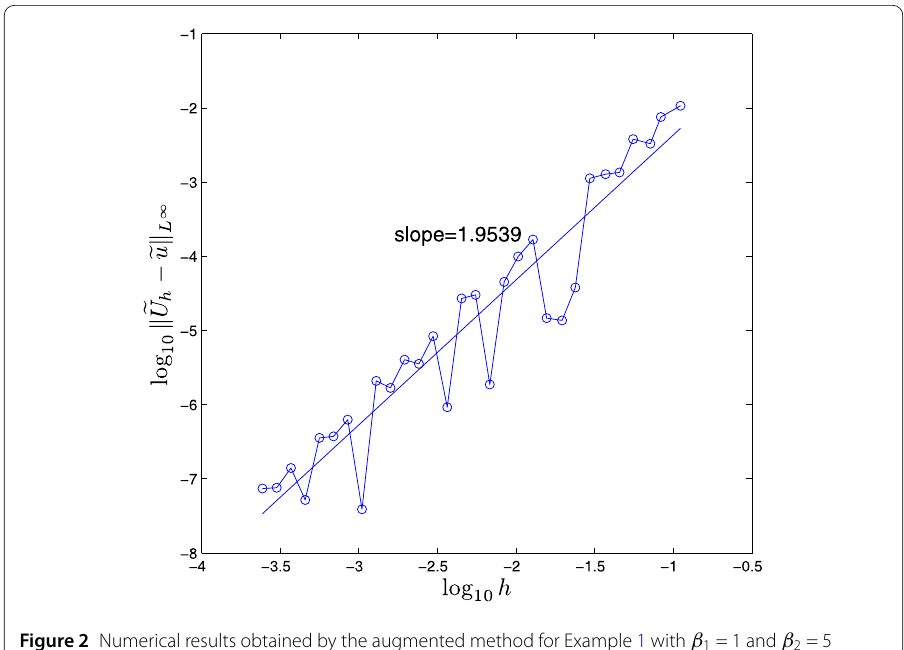
Figure 2 Numerical results obtained by the augmented method for Example 1 with β 1 = 1 and β 2 = 5